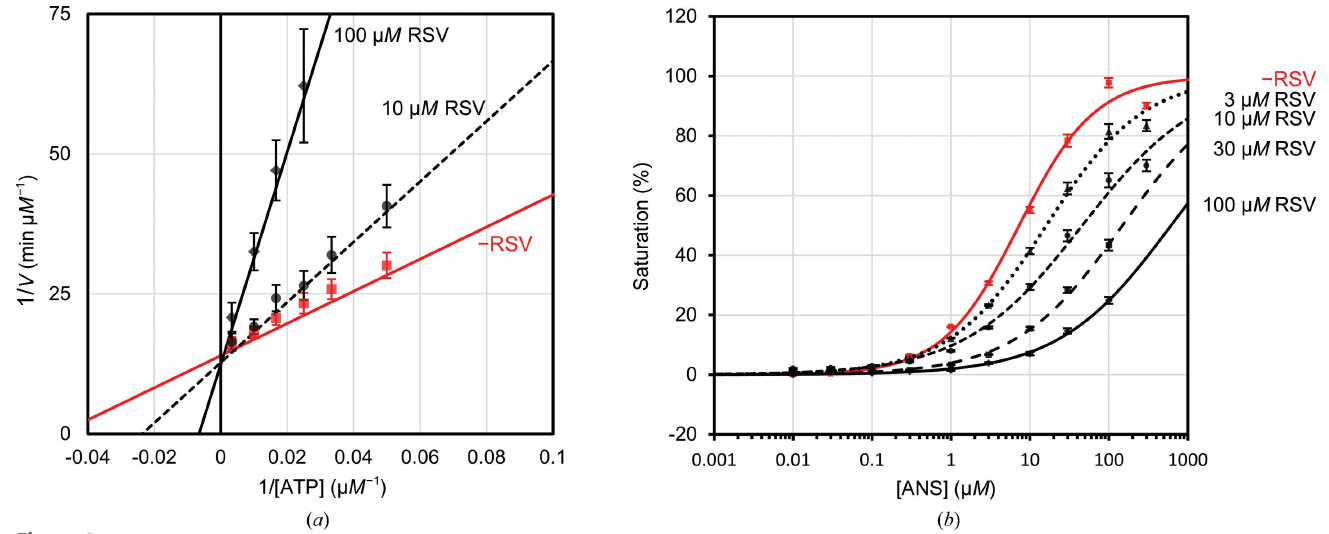
Figure 3 ( a ) The Lineweaver–Burk plot for inhibition of the ATPase activity by RSV demonstrates a large effect on K m and no effect on K cat . Regression lines are drawn for the mean of at least five experiments. ( b ) Semi-log plot for ANS competitive binding assays in the absence of RSV (red continuous line) and in the presence of 3 m M RSV (black dotted line), 10 m M RSV (black short-dashed line), 30 m M RSV (black long-dashed line) and 10 m M RSV (black continuous line). RSV decreased the BC 50 values in a dose-dependent